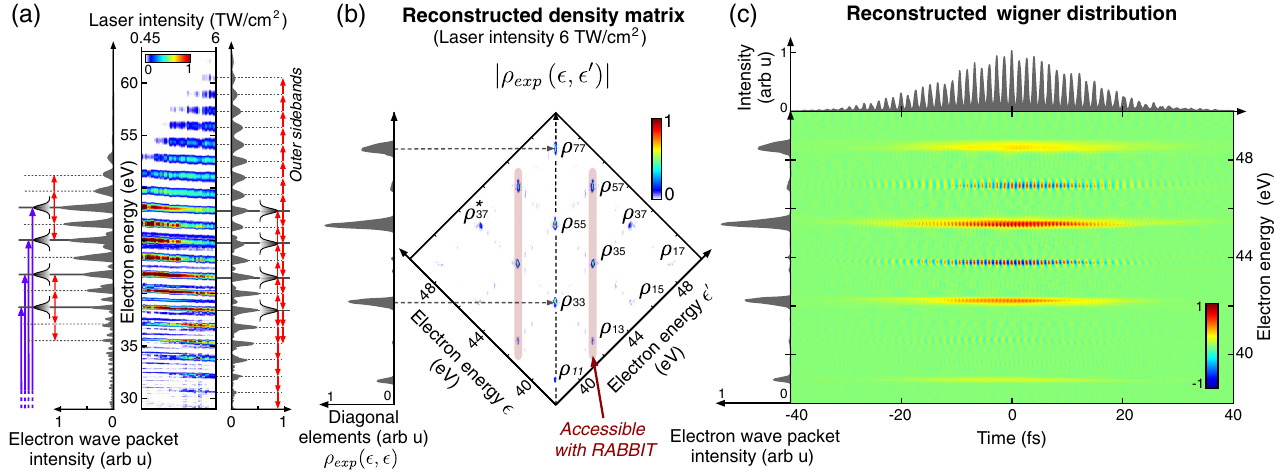
FIG. 2. Implementation of Mixed FROG for an attosecond pulse train generated in neon and photoionizing neon in the 2 p valence shell. (a) The left and right show the photoelectron spectra for laser intensities of 4 . 5 × 10 11 and 6 × 10 12 W · cm − 2 , respectively. The central panel gives the evolution of the spectrum between these two intensities: The linear drift in energy of the peaks observed when the intensity is increased corresponds to the laser-induced ponderomotive shift [43]. Increasing the dressing intensity enables the electron wave packet to emit or absorb more laser photons, which is confirmed by the appearance of numerous “ outer ” sidebands in the photoelectron spectrum [40,44]; see the right. When multi-laser-photon transitions allow the first and last populated levels to interfere, the highest-order coherence becomes encoded into the spectrum, and the full density matrix can be obtained. (b) Retrieved density ϵ ; ϵ 0 Þ (only the modulus shown) for a dressing laser intensity of 6 × 10 12 W · cm − 2 . The dark gray matrix in the energy domain ρ exp ð shaded curve on the left gives the diagonal elements, that is, the laser-free photoelectron spectrum. (c) Reconstructed Wigner distribution W ϵ ; t Þ . Its projections onto the temporal (upper) and energy axes (left), respectively, correspond to the average time profile of the exp ð electron wave packet and the laser-free photoelectron